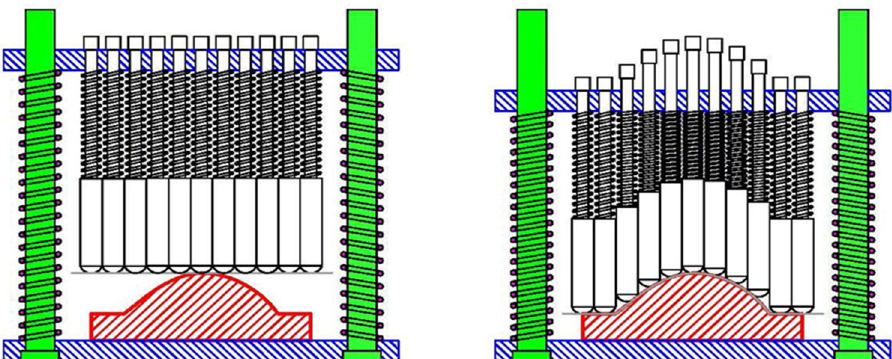
Fig. 4. Schematic the multi-point forming die (without load, and after applying the load when finishing forming process).